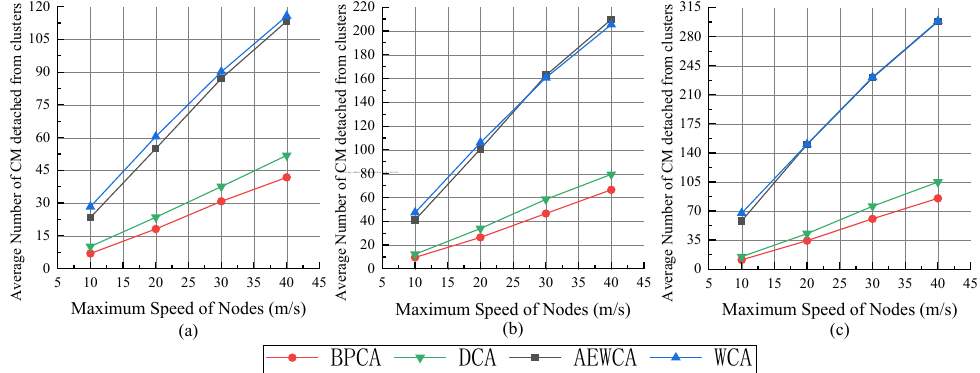
Figure 7. The effects of maximum movement speed on the average number of CM detached from clusters. ( a ) Number of nodes is 100; ( b ) number of nodes is 150; ( c ) number of nodes is 200. Figure 7 represents the relationship between the average number of CM detached from clusters and a node’s maximum movement speed. It can be seen in Figure 7 that the number of the average number of CM detached from clusters increases with the increasing number of nodes and node speed. The average number of CMs that breaks away from clusters in the BPCA scheme is the lowest compared to other algorithms.